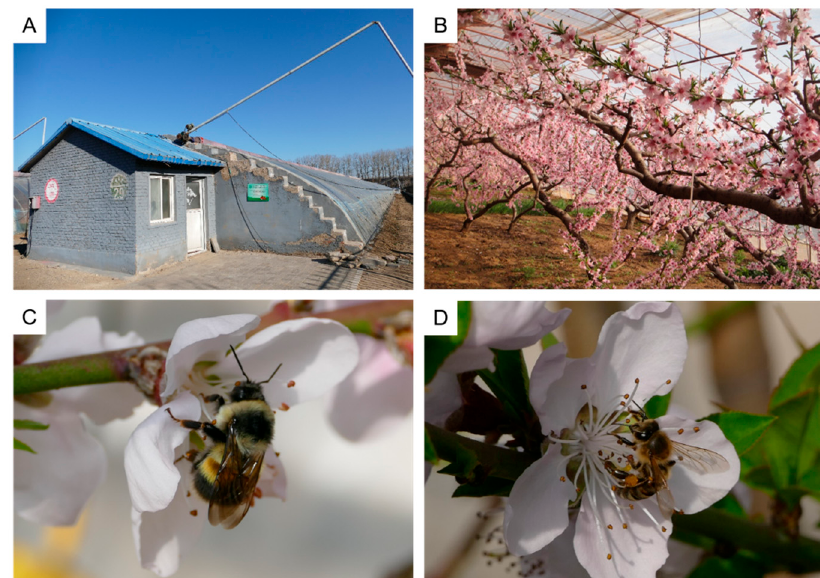
Figure 1. Peach solar greenhouse and bee pollinators. ( A ) Solar greenhouse in northern China; ( B ) peach trees ( Prunus persica “Okubo”) in solar greenhouse; ( C ) worker of Bombus lantschouensis visiting peach flower; and ( D ) worker of Apis mellifera visiting peach flower.